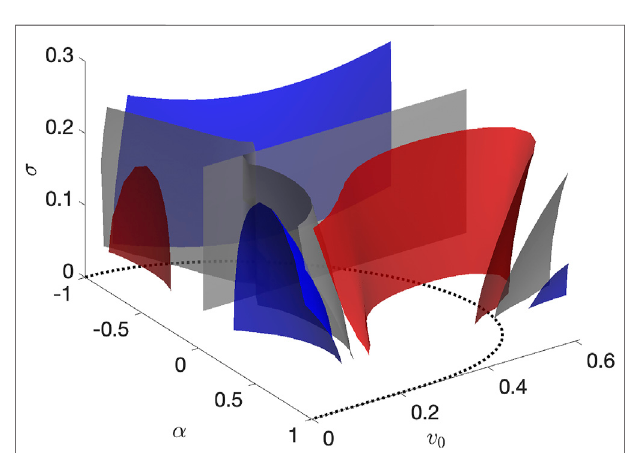
FIGURE 6 | Isosurfaces of the depletion index I D in the ( v 0 , α , σ ) parameter space. Blue surfaces: I D (cid:1) − 0.15. Grey surfaces: I D (cid:1) 0. Red surfaces: I D (cid:1) 0.1. The black dotted curve in the ( v 0 , α ) plane is the bifurcation curve shown in Figure 3